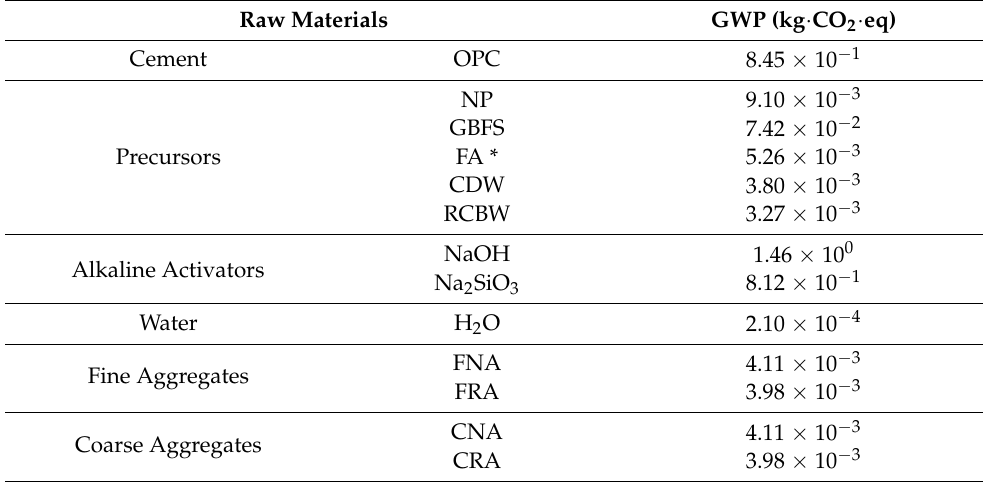
Table 6. Emissions inventory (global warming potential (GWP): kg · CO 2 · eq) of the raw materials used in the production of the blocks. Data source: Ecoinvent 3.6